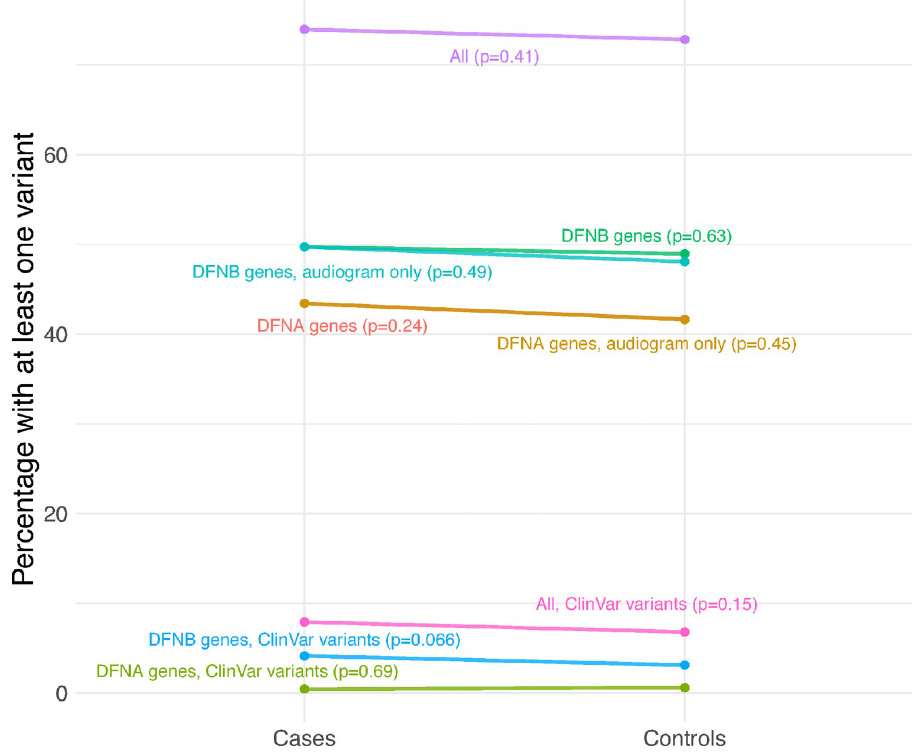
Fig 2. Percentage of hearing loss (HL) cases and controls with at least one variant in different gene and variant categories. “All” refers to the full list of known HL genes, “DFNB” and “DFNA” percentages are only for genes with recessive and dominant forms of Mendelian inheritance, respectively, “audiogram only” percentages are restricted to only individuals with audiograms, and percentages with “ClinVar variants” only included variants with pathogenic/ likely pathogenic ClinVar annotations. P-values from Fisher’s exact test of case versus control carrier counts.